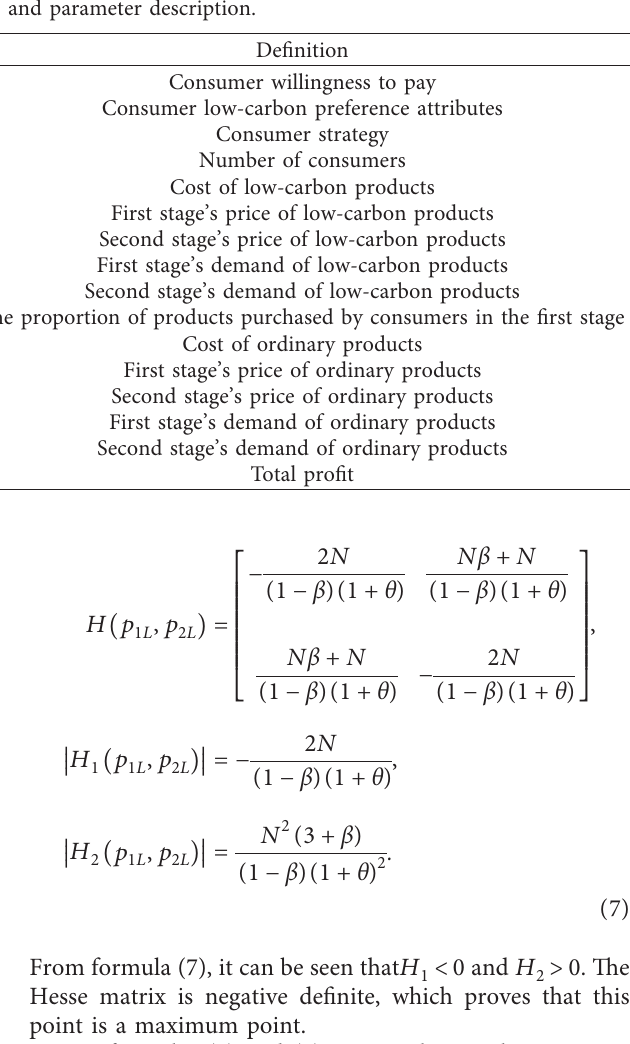
Table 1: Main parameters and parameter